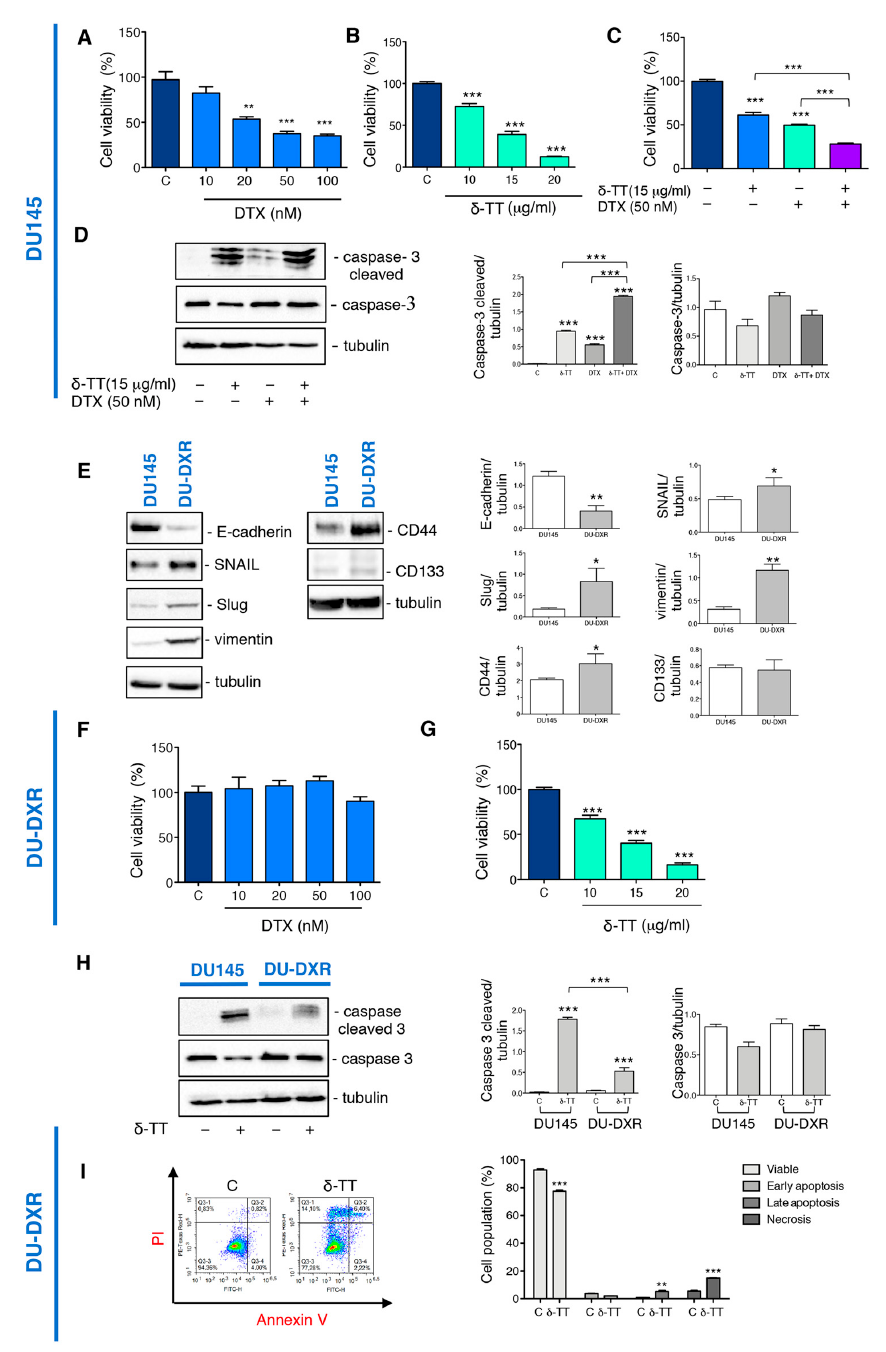
Figure 4. δ -TT potentiates docetaxel (DTX) response in DU145 cells and counteracts DTX-resistance in DU-DXR cells. ( A ) Cell viability analysis after DTX treatment (from 10 to 100 nM doses, 24 h) was determined by MTT assay in DU145 cells. Six independent biological samples for each condition were analyzed ( n = 6); bar graph represents the mean relative cell viability ± SD. Statistical analysis was performed using one-way ANOVA followed by Dunnet post-hoc test (** = p < 0.01 vs. C; *** p < 0.001 vs. C). ( B ) Cell viability analysis after δ -TT treatment (from 10 μ g/mL to 20 μ g/mL, 24 h) was determined by MTT assay in DU145 cells. Six independent biological samples for each condition were analyzed ( n = 6); bar graph represents the mean relative cell viability ± SD. Statistical analysis was performed using one-way ANOVA followed by Dunnet post-hoc test (*** p < 0.001 vs. C). ( C ) Cell viability analysis after δ -TT treatment (15 μ g/mL, 24 h) in combination with or without DTX (50 nM, 24 h) was determined by MTT assay in DU145 cells. Six independent biological samples for